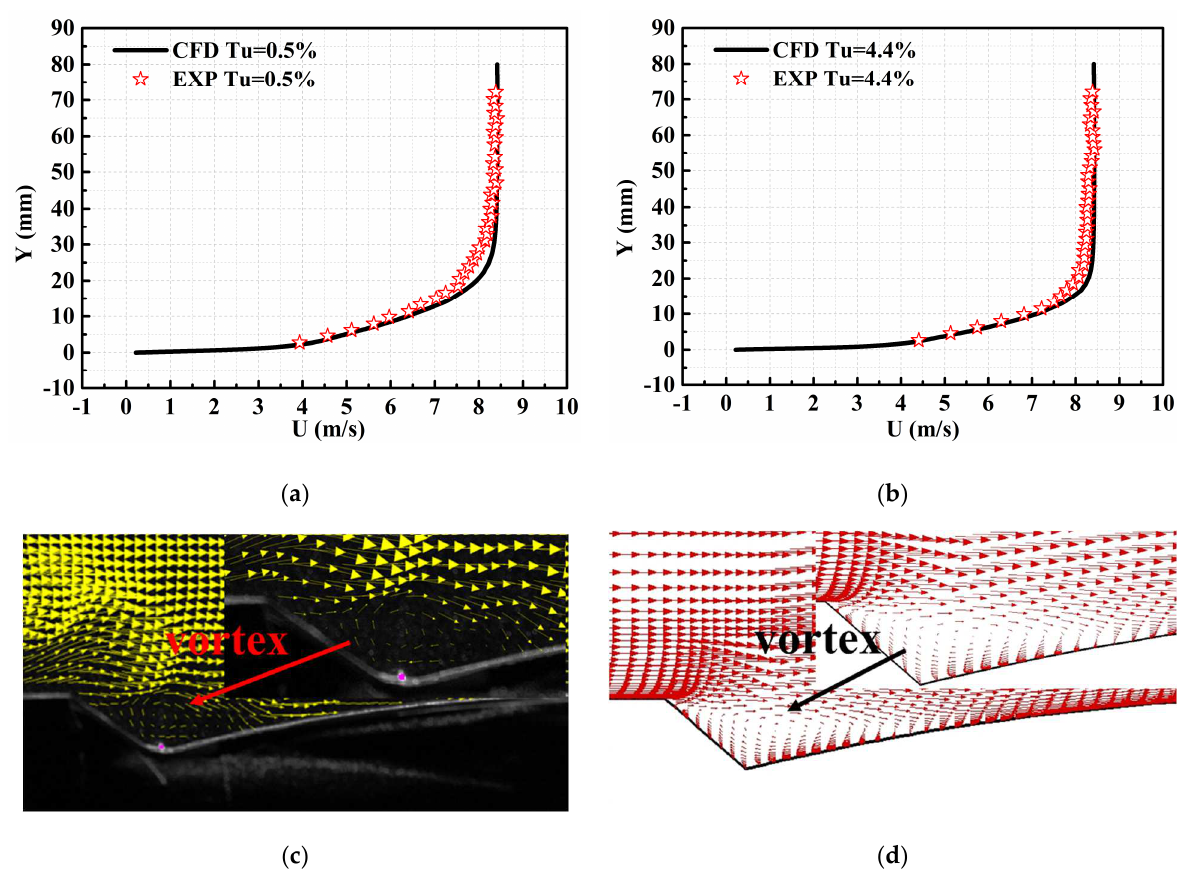
Figure 16. Comparison of simulated velocity profiles with the experimental results of Ahmadi- Baloutaki et al. [41] when the turbulence intensity is ( a ) 0.5% and ( b ) 4.4%; the velocity vectors obtained ( c ) experimentally [42] and ( d ) numerically inside the groove.